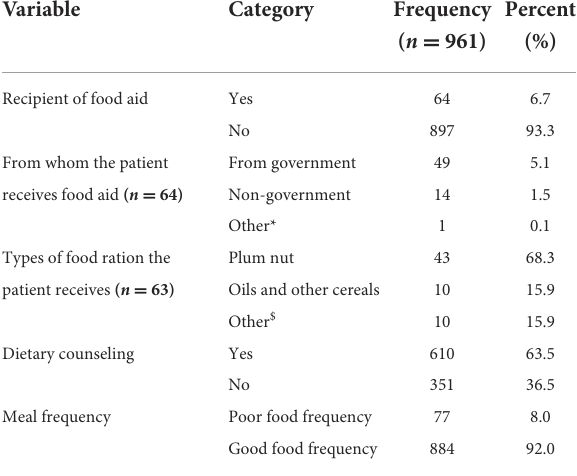
TABLE 4 Nutritional-related factors of the study participants at Bench Maji Zone, Ethiopia, 2018. Variable ( n = 961) (%)